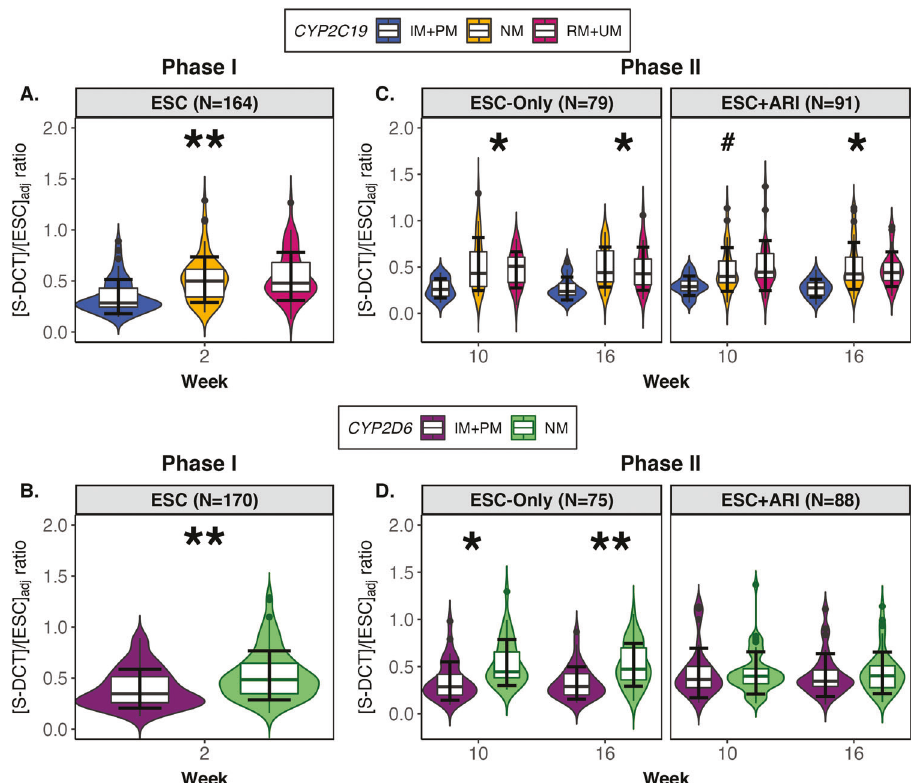
Fig. 5 Dose-adjusted serum S-DCT/ESC adj ratio for Phase I and II by CYP2C19 and CYP2D6 metabolizer groups. During Phase I, A CYP2C19 and B CYP2D6 IM + PMs showed lower mean S-DCT ad /ESC adj ratio relative to NMs. Likewise, during Phase II, in the ESC-Only and ESC + ARI treatment arms, C CYP2C19 IM + PMs compared to NMs had lower mean S-DCT ad /ESC adj ratio in serum. D For CYP2D6 , IM + PMs displayed lower S-DCT ad /ESC adj ratio in ESC-Only, whereas S-DCT ad /ESC adj ratio was not associated with CYP2D6 metabolizer group in the ESC + ARI treatment arm. All linear regression analyses were adjusted for age, ancestry, sex, site, time since last dose, CYP2C19 and CYP2D6 metabolizer groups. Error bars represent standard error. ARI aripiprazole, ESC escitalopram, IM intermediate metabolizer, NM normal metabolizer, PM poor metabolizer, RM rapid metabolizer, UM ultra-rapid metabolizer. * q < 0.05; ** q < 0.01; *** q <